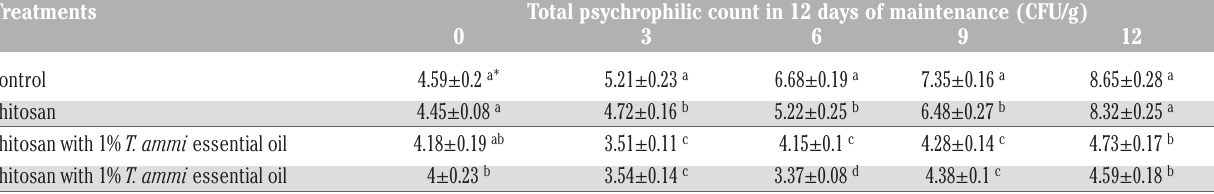
Table 2. Levels of total psychrophilic count for various treatments of chicken fillet on maintenance period.